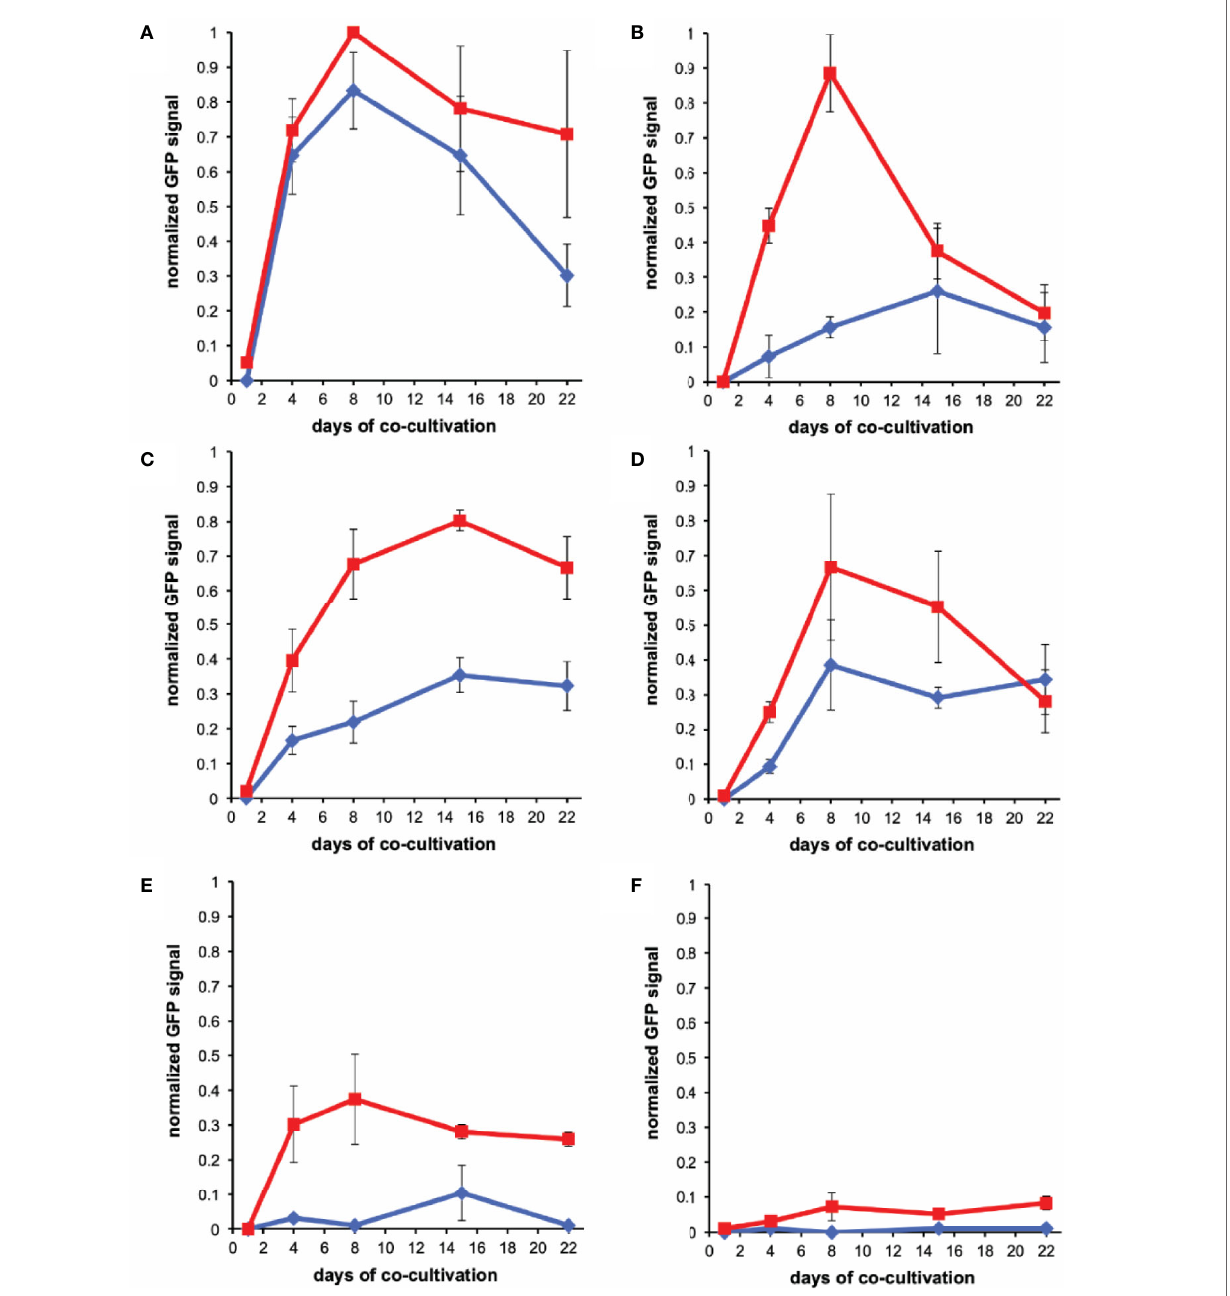
FIGURE 5 | Quanti fi cation of wound-induced virulence inducers by co-cultivation. Bacteria were co-incubated with plant explants, vortexed, and GFP intensity was determined using fl ow cytometry (see Methods). Experiments were performed in triplicate and error bars represent ± SE. AB650 wt (blue diamonds) or YHL301 ss (red squares) with tobacco midrib explants on glucose plates (A) , maize midrib explants on glucose plates (B) , tobacco midrib explants on acetosyringone (AS) plates (C) , maize midrib explants on AS plates (D) , tobacco midrib explants on glycerol plates (E) , and maize midrib explants on glycerol plates (F)